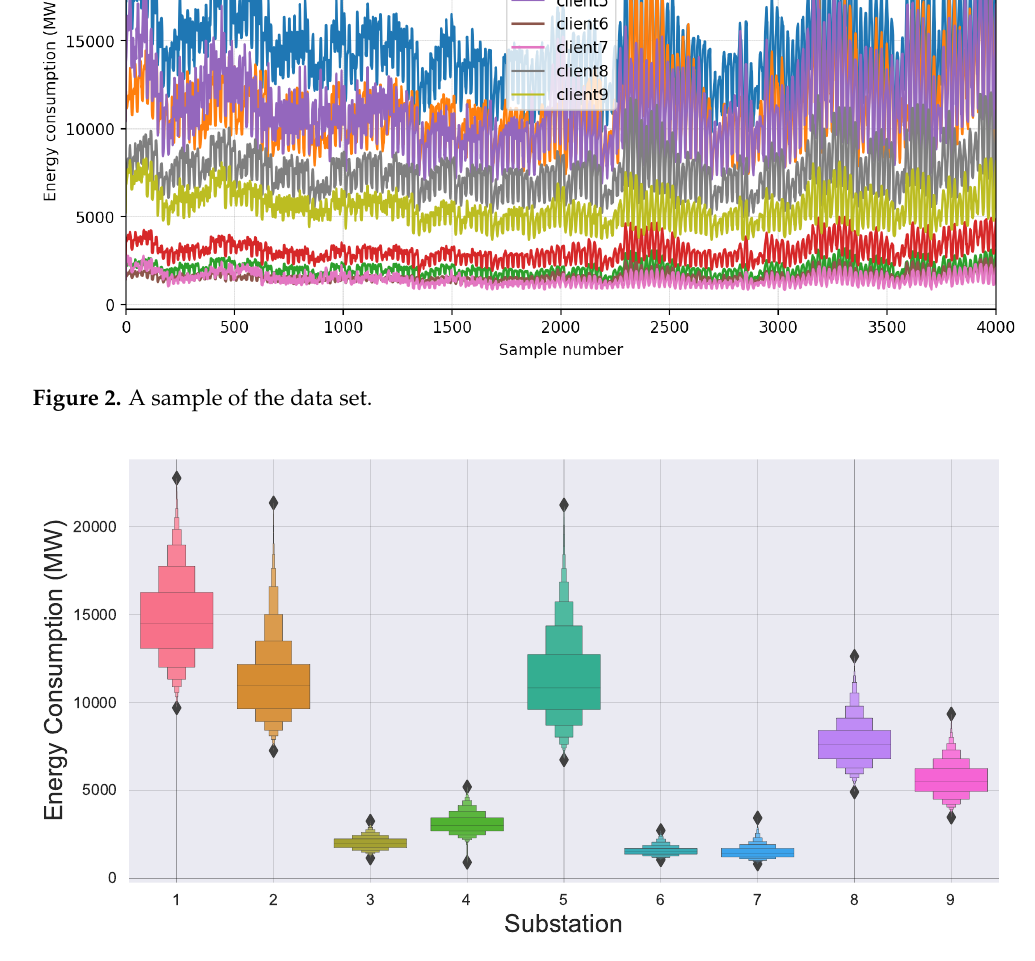
Figure 3. Diversity visualization of the data